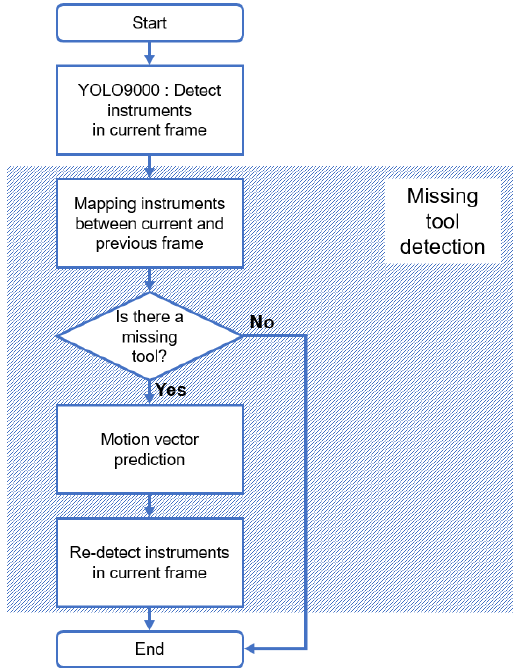
Figure 1. Flow chart of the proposed algorithm. The top rectangle is the detection step of the surgical tool in the current frame using YOLO9000, and the rest in the upper-right direction pattern corresponds to the missing tool detection